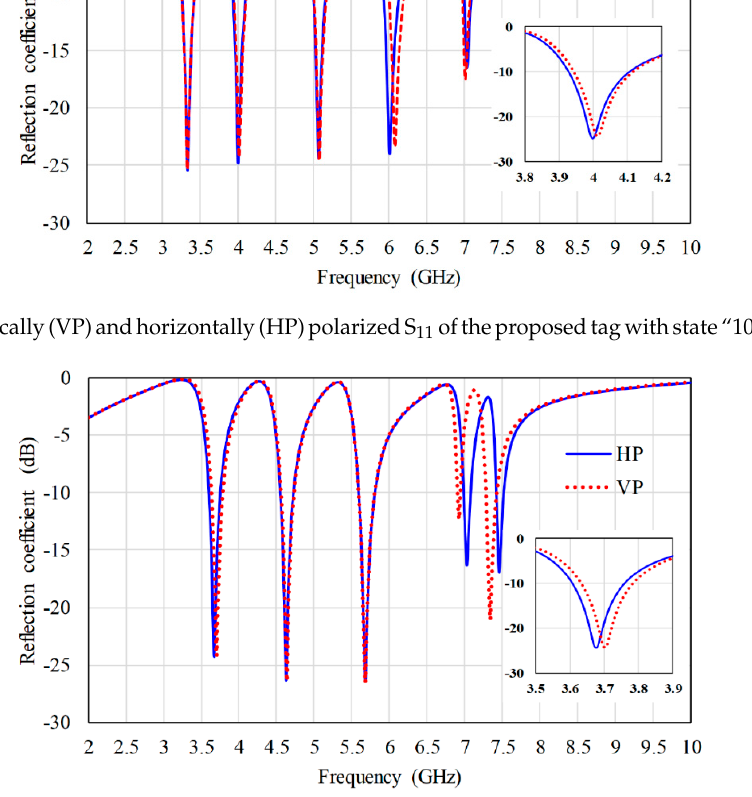
Figure 7. Vertically (VP) and horizontally (HP) polarized S 11 for code “0101010101”.